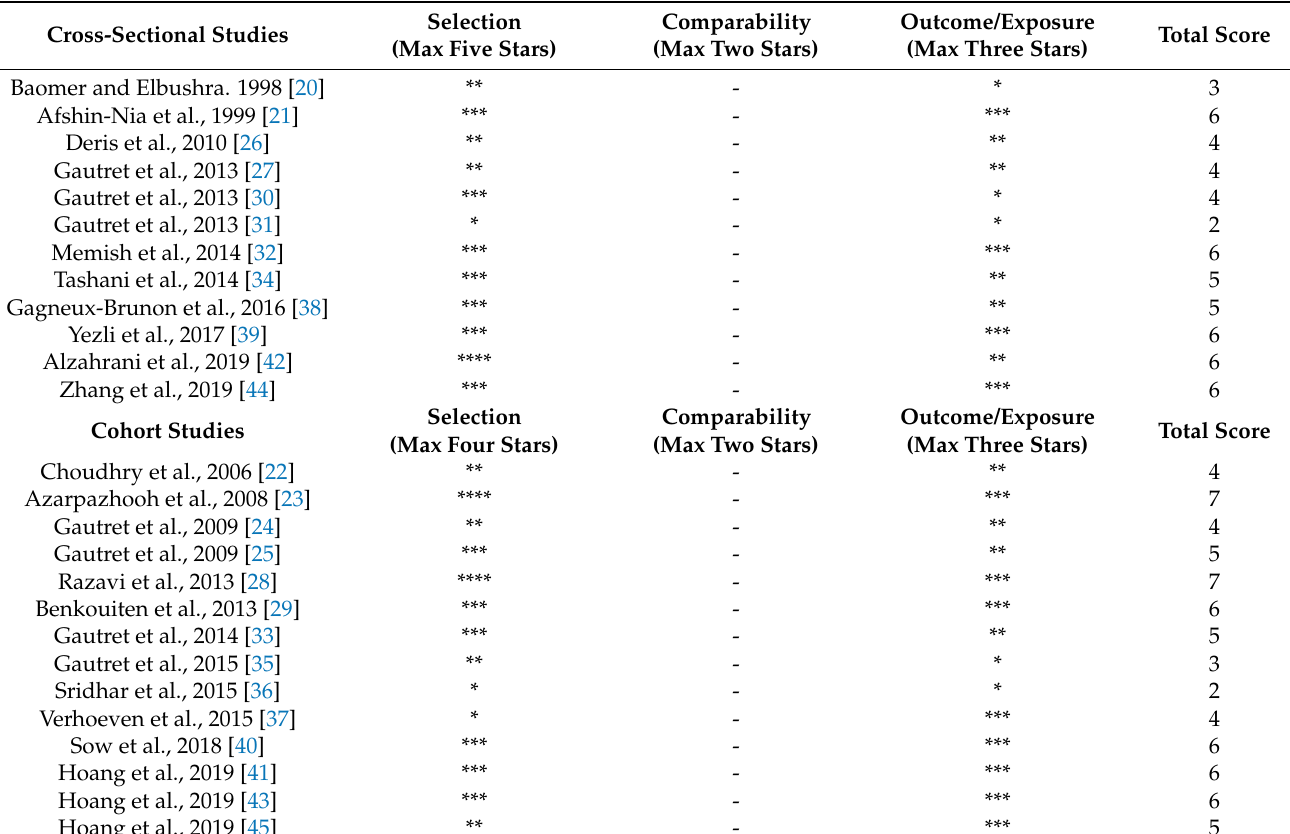
(Table 1). The weighted pooled prevalence rate of hypertension among Hajj pilgrims in all included studies was 12.2% (95% CI: 12.0–12.3). Table 2. Newcastle–Ottawa Scale (NOS) scores for the included